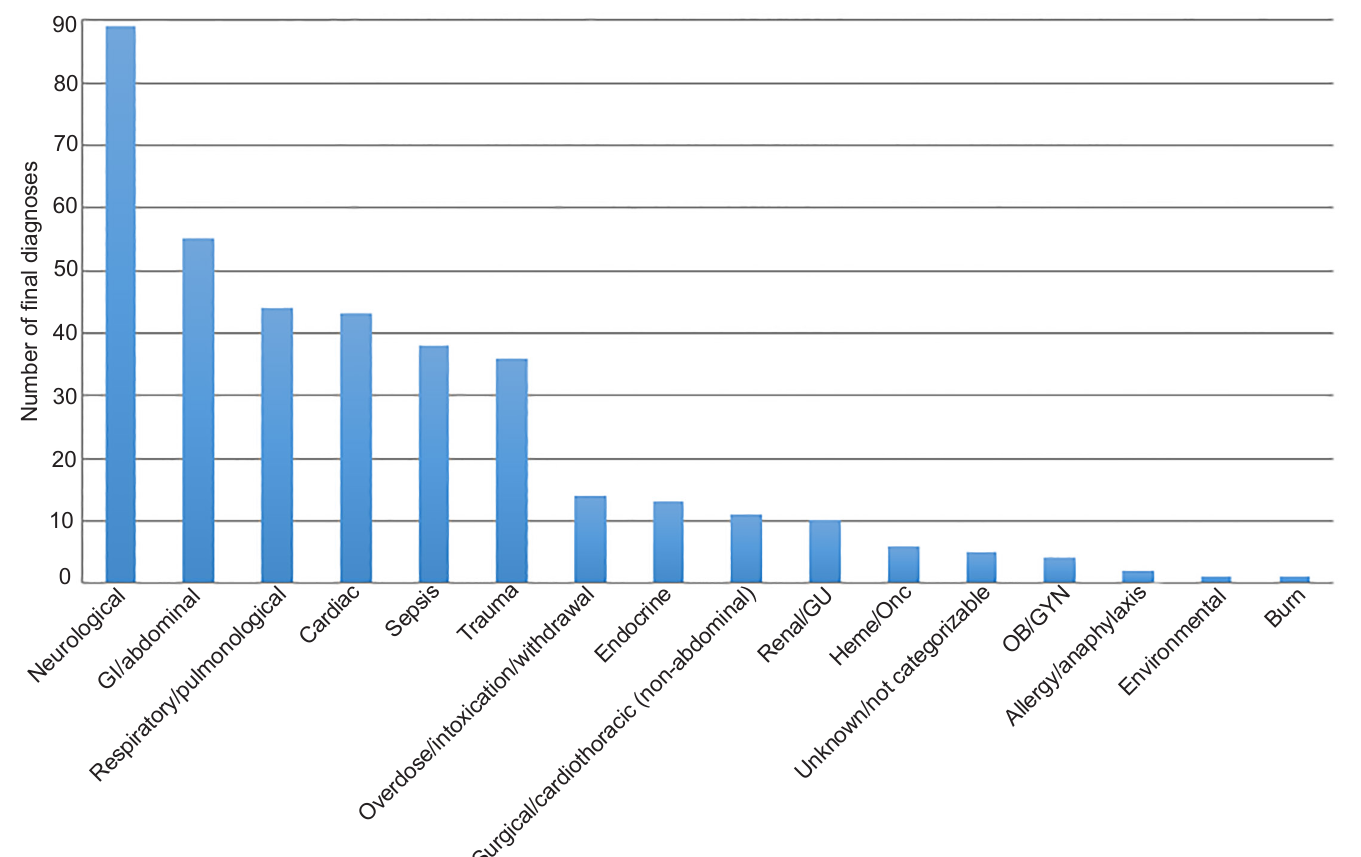
Figure 1. Number of admission diagnosis categories for patients triaged to basic life support and admitted to critical care location. GI, gastrointestinal; GU, genitourinary; Heme/Onc, hematology/oncology; OB/GYN, obstretics/gynecology.